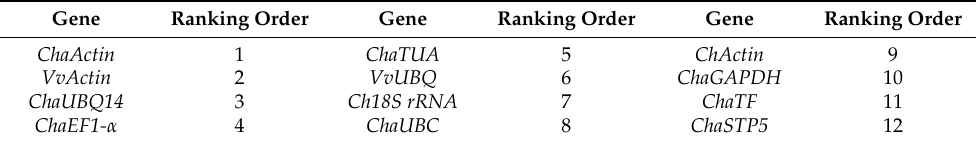
Table 7. Stability rankings of 12 candidate reference genes in all